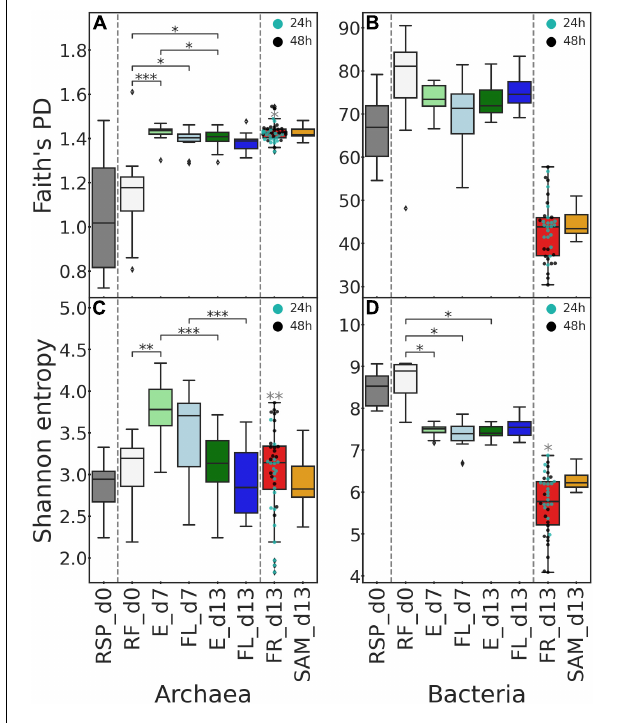
FIGURE 3 | Alpha diversity indices by sample type and sampling day. Faith’s phylogenetic diversity (A,B) and Shannon entropy index (C,D) are plotted for archaea (A,C) and bacteria (B,D) . Boxplots visualize the alpha diversity metric distribution across all samples inside a given group. Gray dashed lines subdivide boxes into groups, where pairwise comparisons were performed. Significant after Benjamini–Hochberg correction, P -values of Dunn’s pairwise test are denoted by black asterisks. For FR samples, additional (dots) were plotted, indicating samples taken from bags with 24 and 48 h incubation time. Gray asterisks are plotted above FR samples if the Kruskal–Wallis test indicated a significant difference between samples with different incubation times. Significant P -values denoted as: ∗ P ≤ 0.05, ∗∗ P ≤ 0.01, and ∗∗∗ P ≤